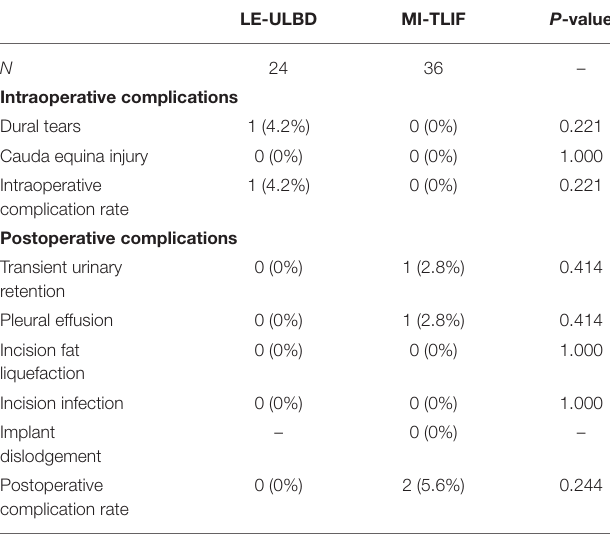
TABLE 7 | Healthcare cost of the two